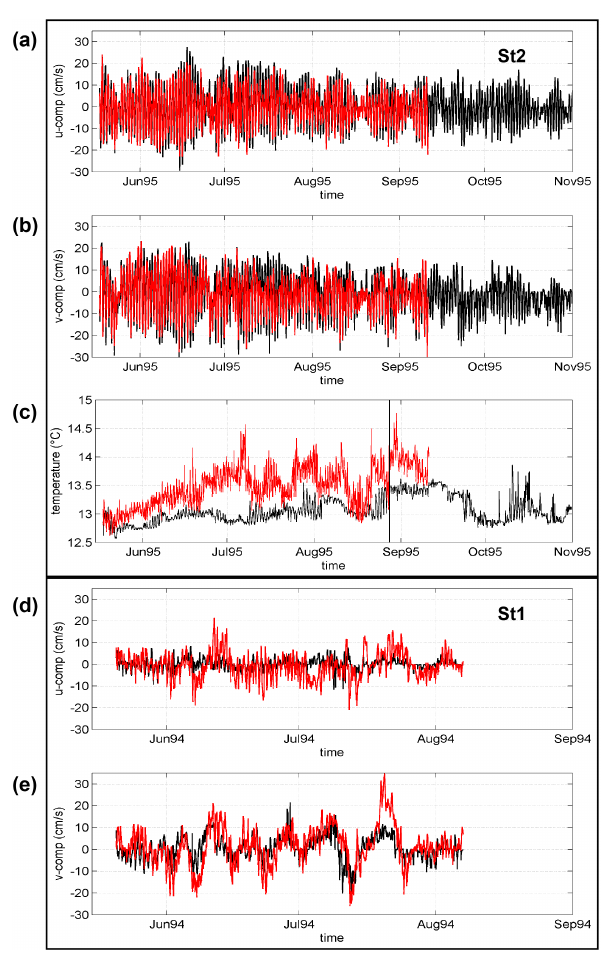
Fig. 11. u and v current components in the upper (red line) and bot- tom (black line) layers at station St2 (a and b) during summer 1995 and at location St1 (d and e) during summer 1994. The temperature time series at station St2 is plotted in (c) ; the time of the CTD cast at St2 referred to in Fig. 10 is indicated by a vertical black